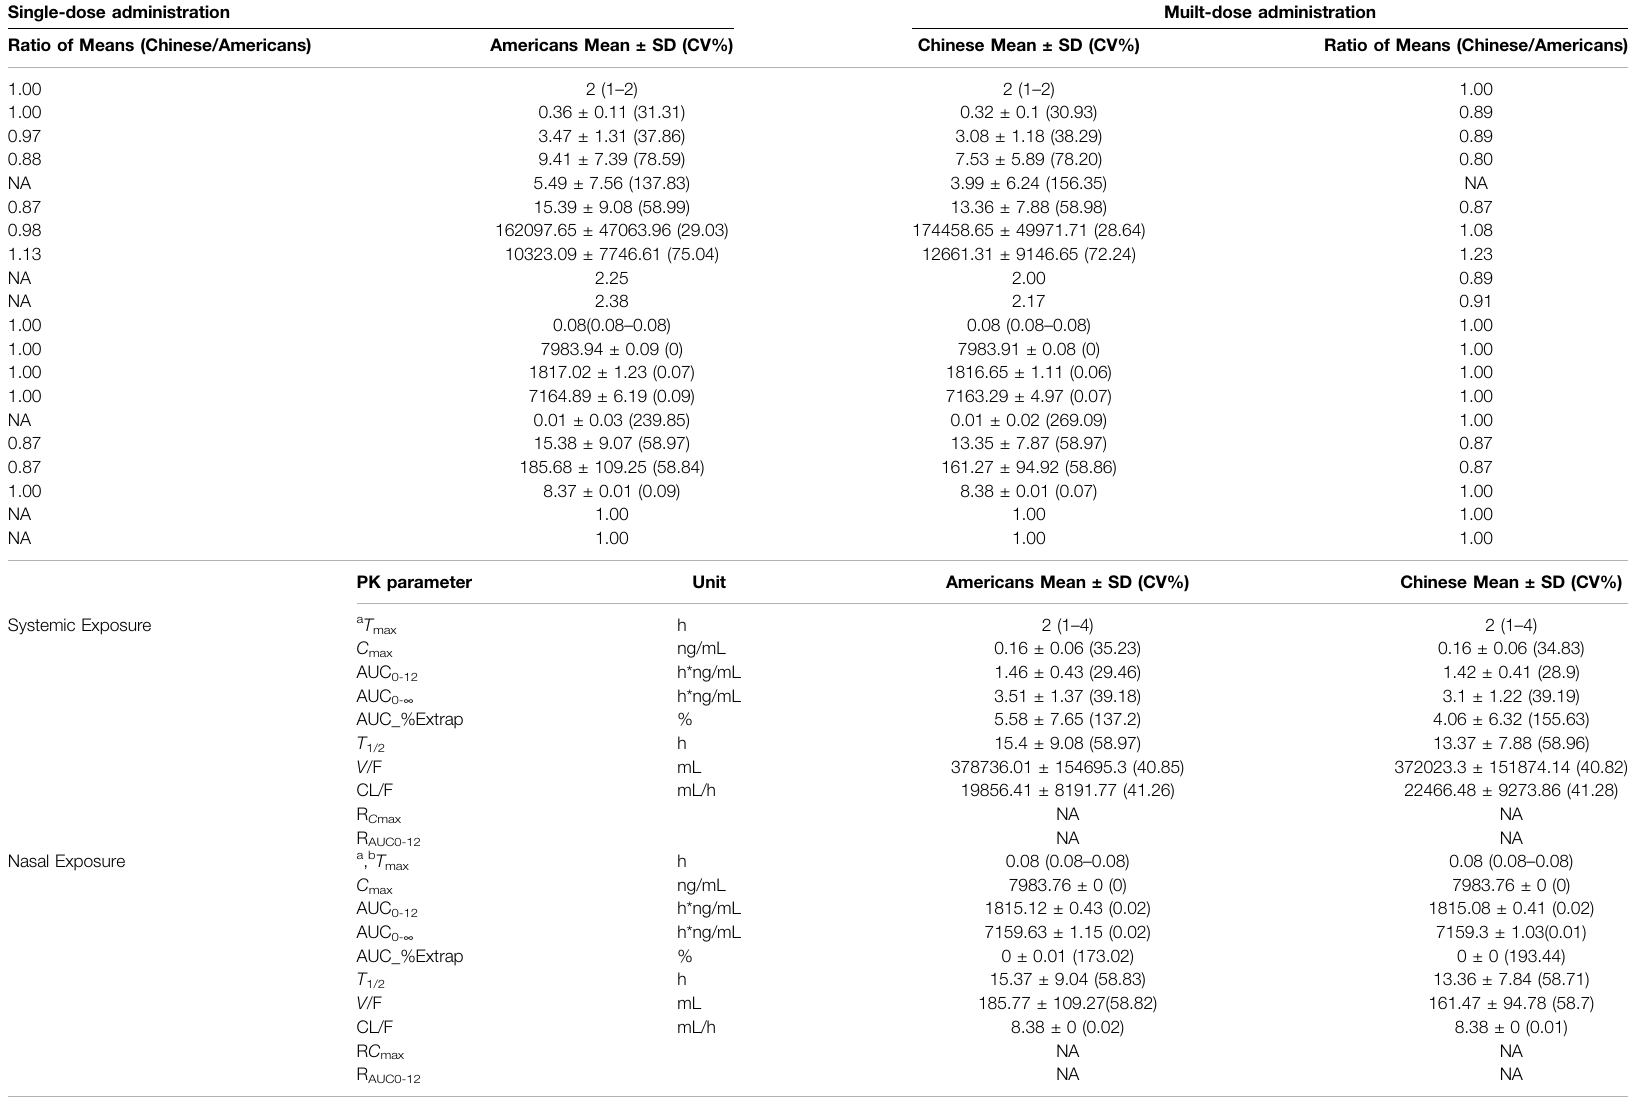
TABLE 6 | The simulated PK parameters in American and Chinese populations following single-dose administration and multidose administration of varenicline nasal spray, (a) systemic; (b) nasal. Single-dose